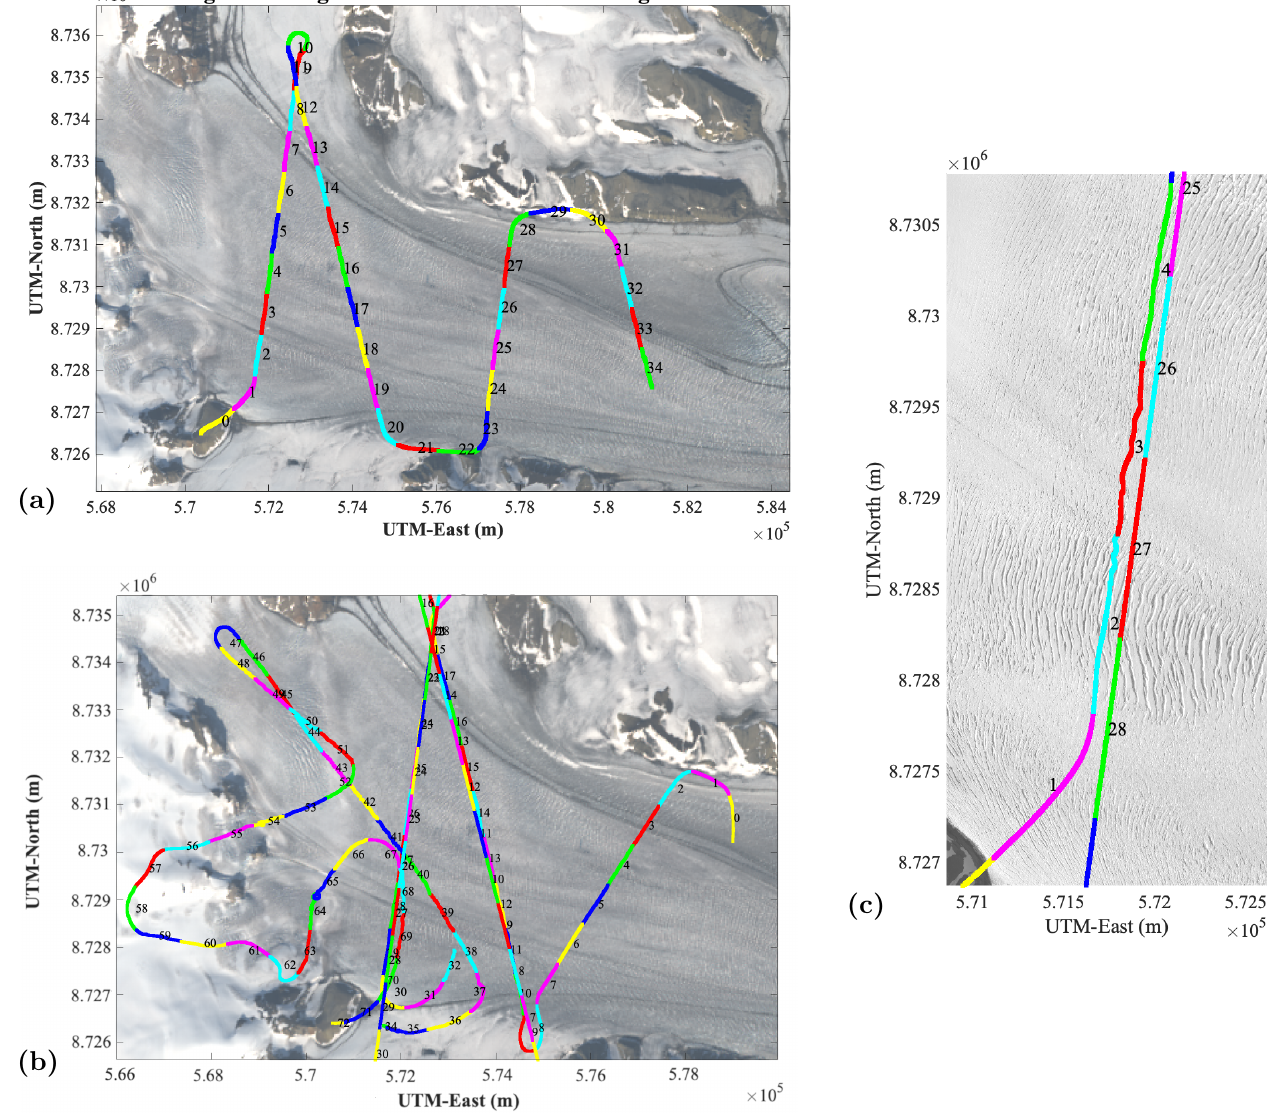
Figure 9. Flight path segments, resultant from ULS data collection, and co-location with ATLAS ground tracks over crevasse fields. Negribreen validation campaign. Flight 2, 13 August 2019. ( a , b ) Flight paths, colored in 1-km segments to match the along-track distance vs. elevation plots in Figures 9–13. Background: Landsat-8 image from 5 August 2019 [LC08_L1TP_215003_20190805_20190820_01_T1]. ( a ) Flight 2, part 1. ( b ) Flight 2, part 2. ( c ) Example of co-located airborne ground track (ULS), left, and ATLAS ground track (RG 450 1l), right. Even with an 18 meter average separation, the airborne ground track (ULS) and the ATLAS ground track cross the same crevasse provinces.